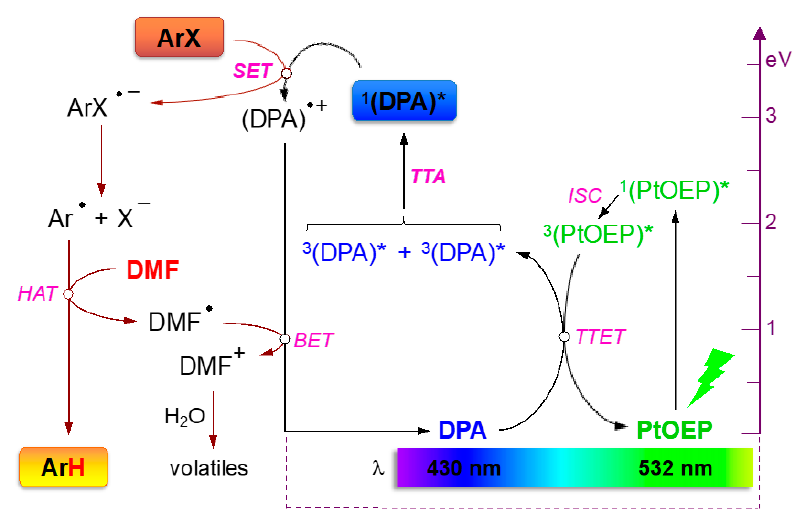
Scheme 1. Proposed mechanism for visible light photoreduction of aryl halides at room temperature in air based on the combination of TTA-UC and SET processes in a gel. Symbol * denotes excited states. Adapted with permission from ref. [10]. Copyright 2015 Royal Society of